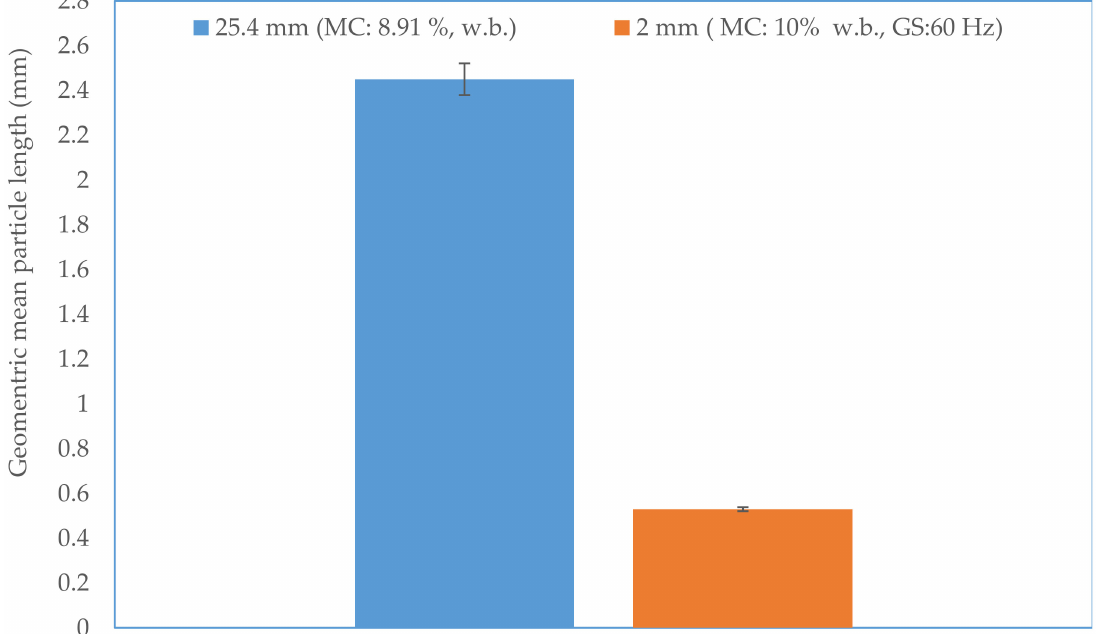
Figure 9. The comparison of geometric mean particle length of the 25.4 mm and 2 mm screen size grind. (Note: GM: grinder speed and MC: corn stover moisture